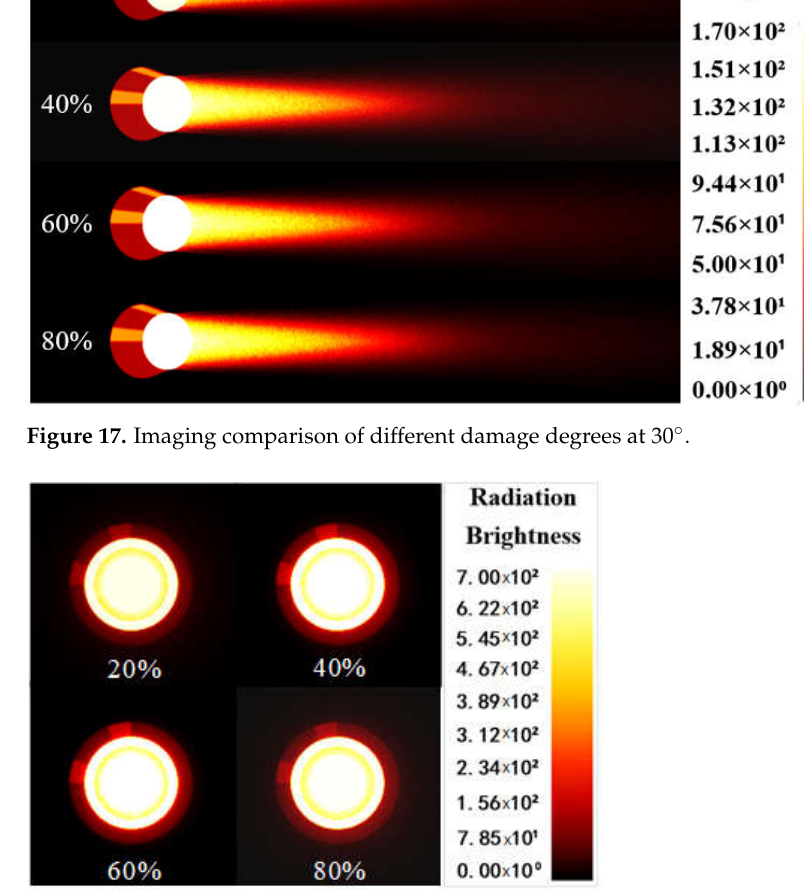
Figure 18. Imaging comparison of different damage degrees at 0°.